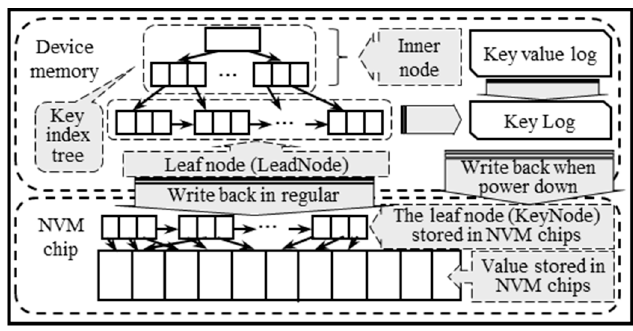
Figure 3. The data layout of PMEKV.